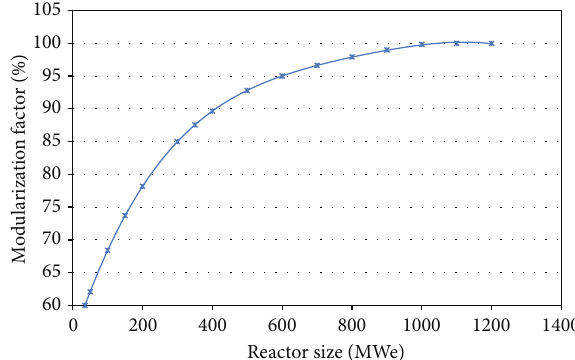
Figure 1: Economy of scale curve.